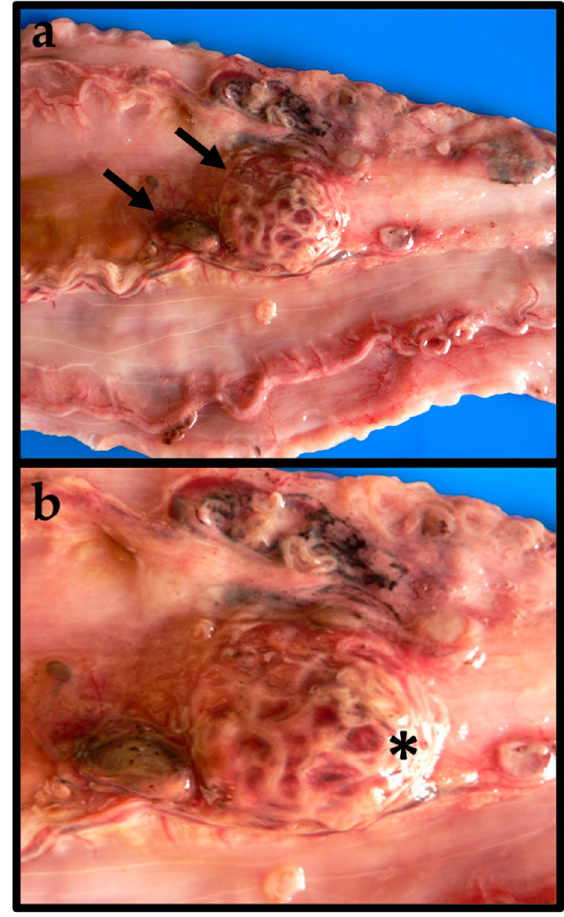
Figure 2. ( a ) Gastric nodular lesions in Sphyraena viridensis caused by Anisakis pegreffii (arrows) . ( b ) Note the presence of numerous A. pegreffii larvae inside the gastric nodule (asterisk). By histology, several nematodes encysted through the gastric wall were found in both sub-serosa and sub-mucosa (Figure 3). Frequently, parasitic bodies were surrounded by a thick granulomatous reaction, made up of macrophages, epithelioid cells, some lymphocytes and an external connective sheet, although singular parasites appeared to be simply encysted within a thin fibrous reactive capsule.